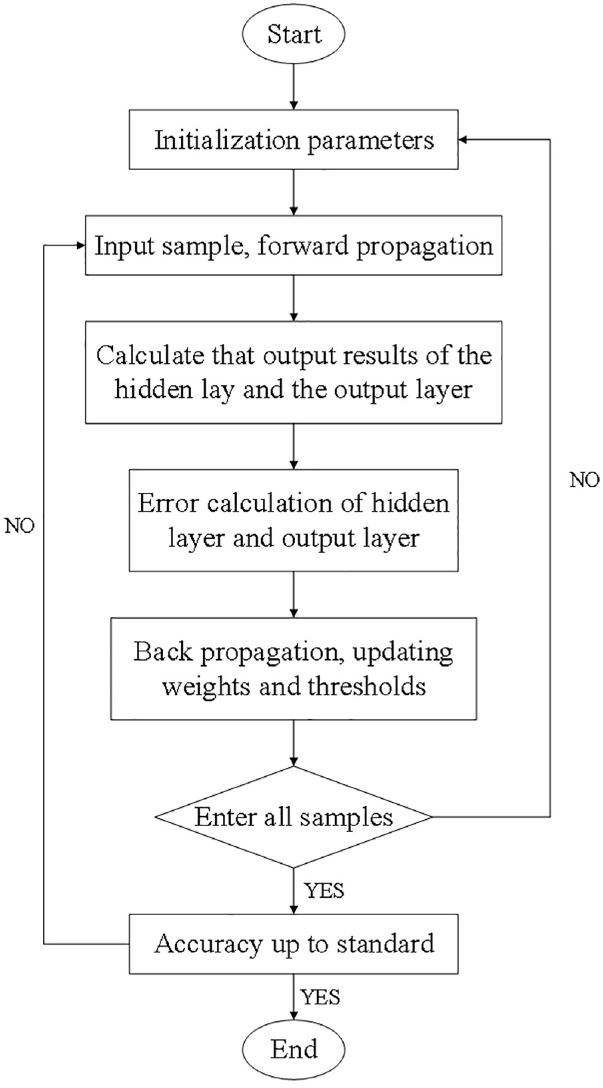
Fig 2. BP neural network algorithm